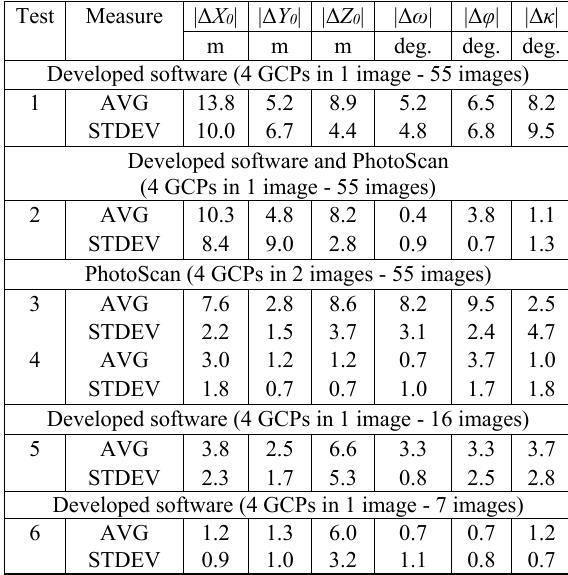
Table 1. Average absolute differences and standard deviation of